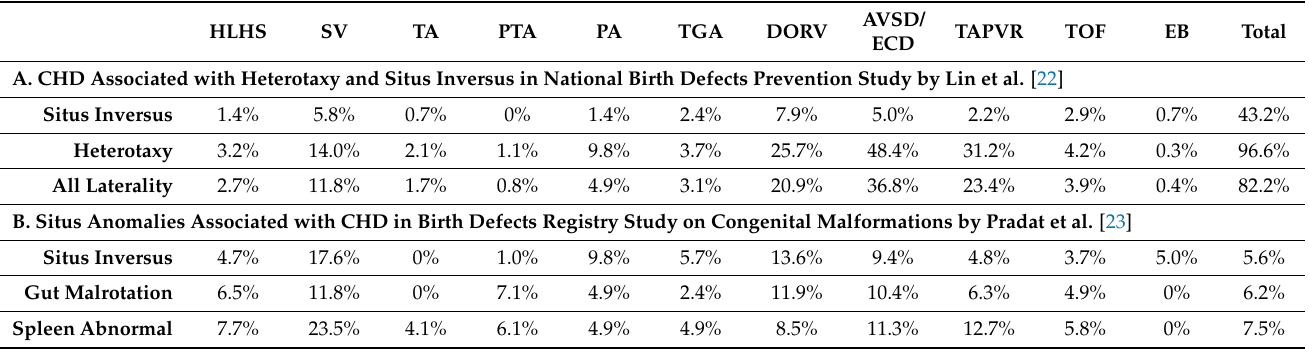
Table 1. Prevalence of Laterality Defects Among Different Types of Congenital Heart Defects